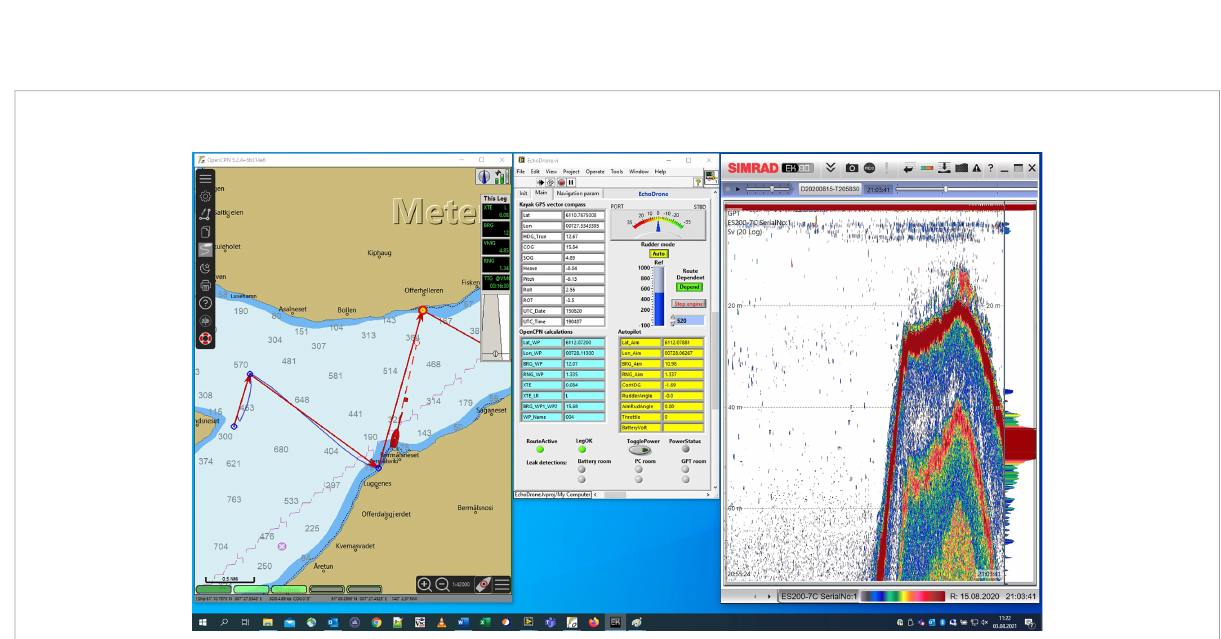
FIGURE 4 The Kayak Drone PC screen as seen in real time by the controller via the VNC radio link. To the left is the OpenCPN chart program. The route is indicated by consecutive red arrows. Next waypoint is indicated by a red circle with yellow fi ll. The drone is shown as a red ship and the actual sailed track of the drone is shown as a blue curved line. In the middle of the screen is the EchoDrone USV control software. To the right is the echo sounder software showing a school of sprat in shallow waters close to the current position near the shore.